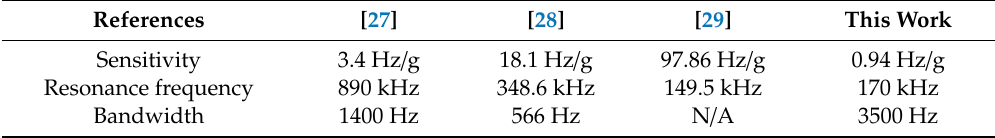
Table 1. Comparison of the sensitivity with other